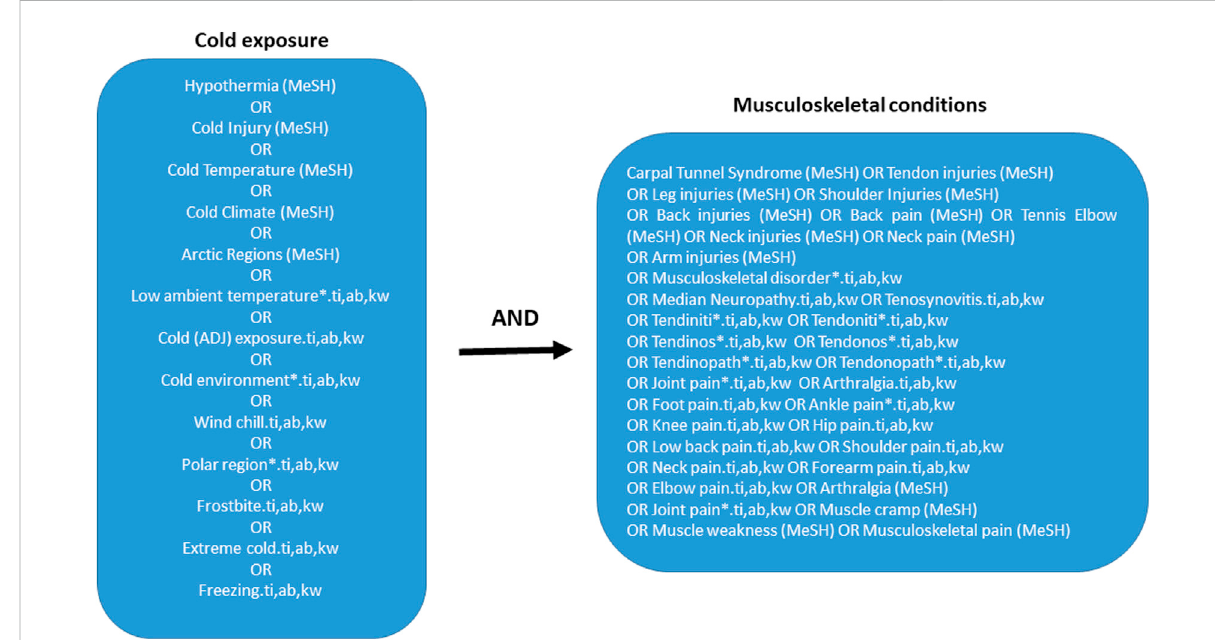
FIGURE 1 SystematicliteraturesearchofFebruary2022inthefollowingdatabases:OvidMEDLINE(R)andEpubAheadofPrint,In-ProcessandOtherNon- Indexed Citations, Daily and Versions(R), and Embase Classic + Embase. 1980 to Present. Medline subject headings; ti, titles; ab, abstracts; kw, keywords.